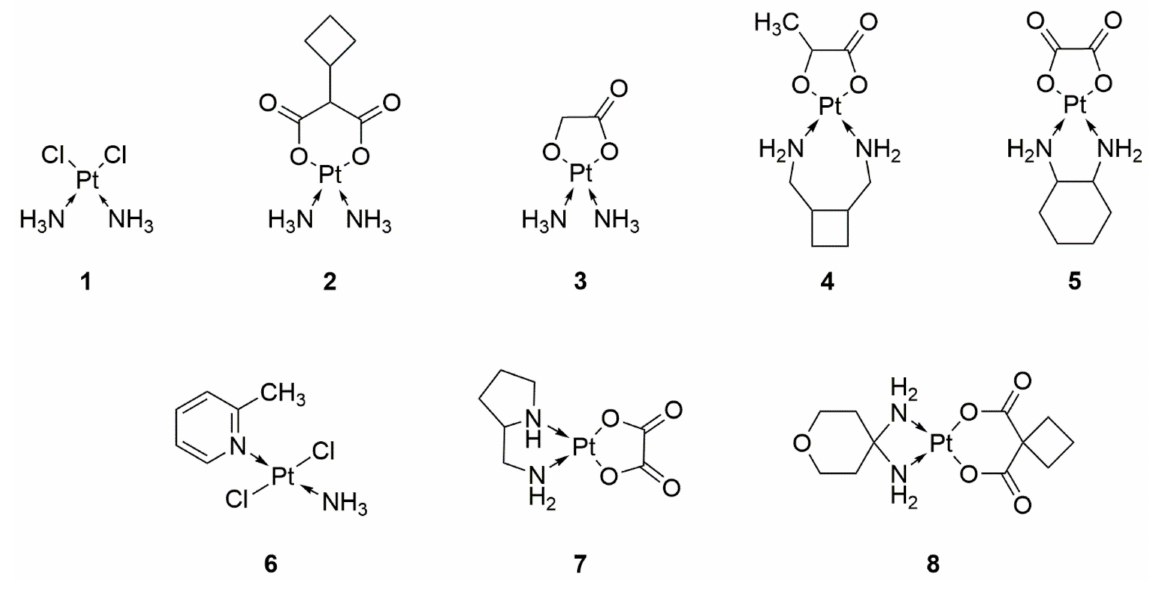
Figure 1. Structures of clinically used platinum anticancer drugs ( 1 —cisplatin, 2 —carboplatin, 3 —nedaplatin, 4 —lobaplatin, 5 —oxaliplatin, 6 —picoplatin, 7 —miboplatin, 8